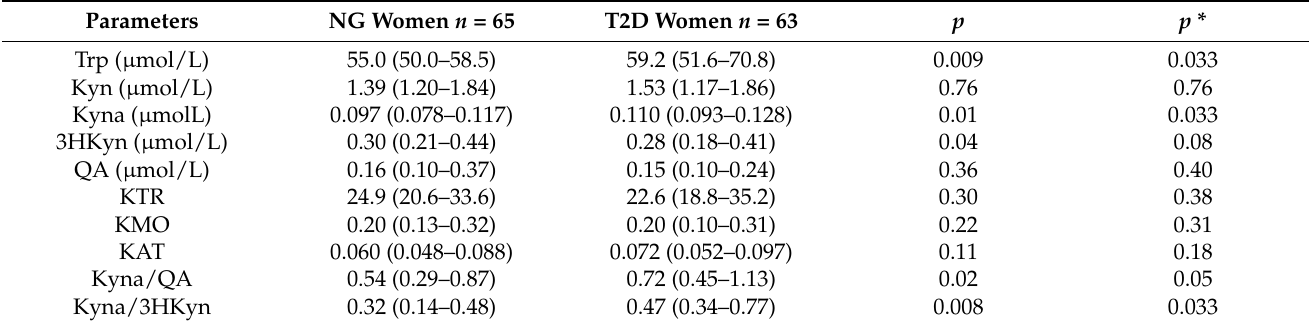
Table 2. The values of tryptophan and KP metabolites in obese NG and T2D women.